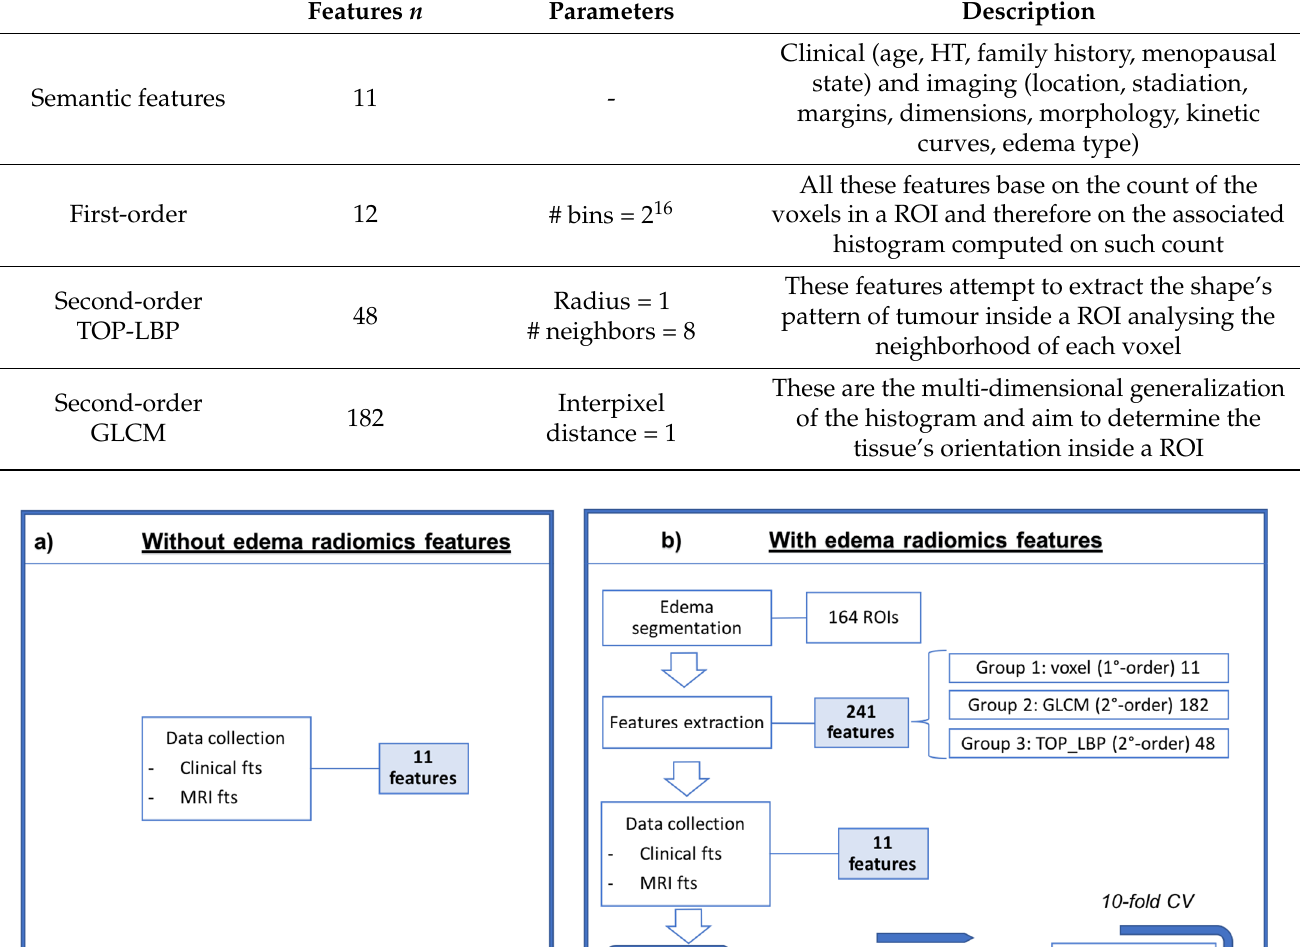
Table 1. Description of the extracted features. #: “number of”.